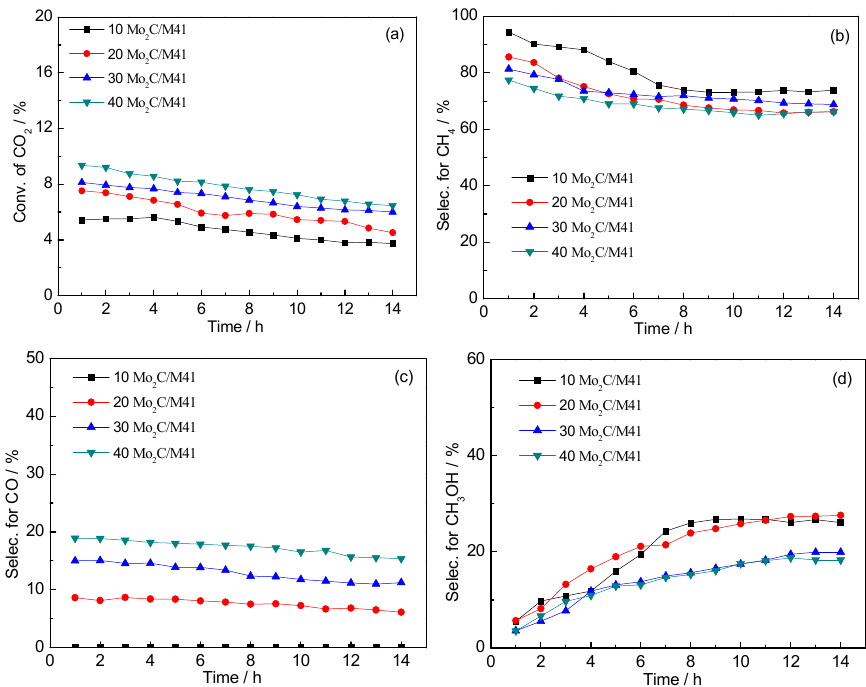
Figure 5. Catalytic performance of y Mo 2 C/M41 in CO 2 hydrogenation. ( a ) CO 2 conversion; ( b ) CH 4 selectivity; ( c ) CO selectivity; ( d ) CH 3 OH selectivity. Reaction conditions: catalyst 0.5 g, temperature 493 K, pressure 3.0 MPa (H 2 :CO 2 = 3:1), GHSV 3600 mL/(h ∙ g).